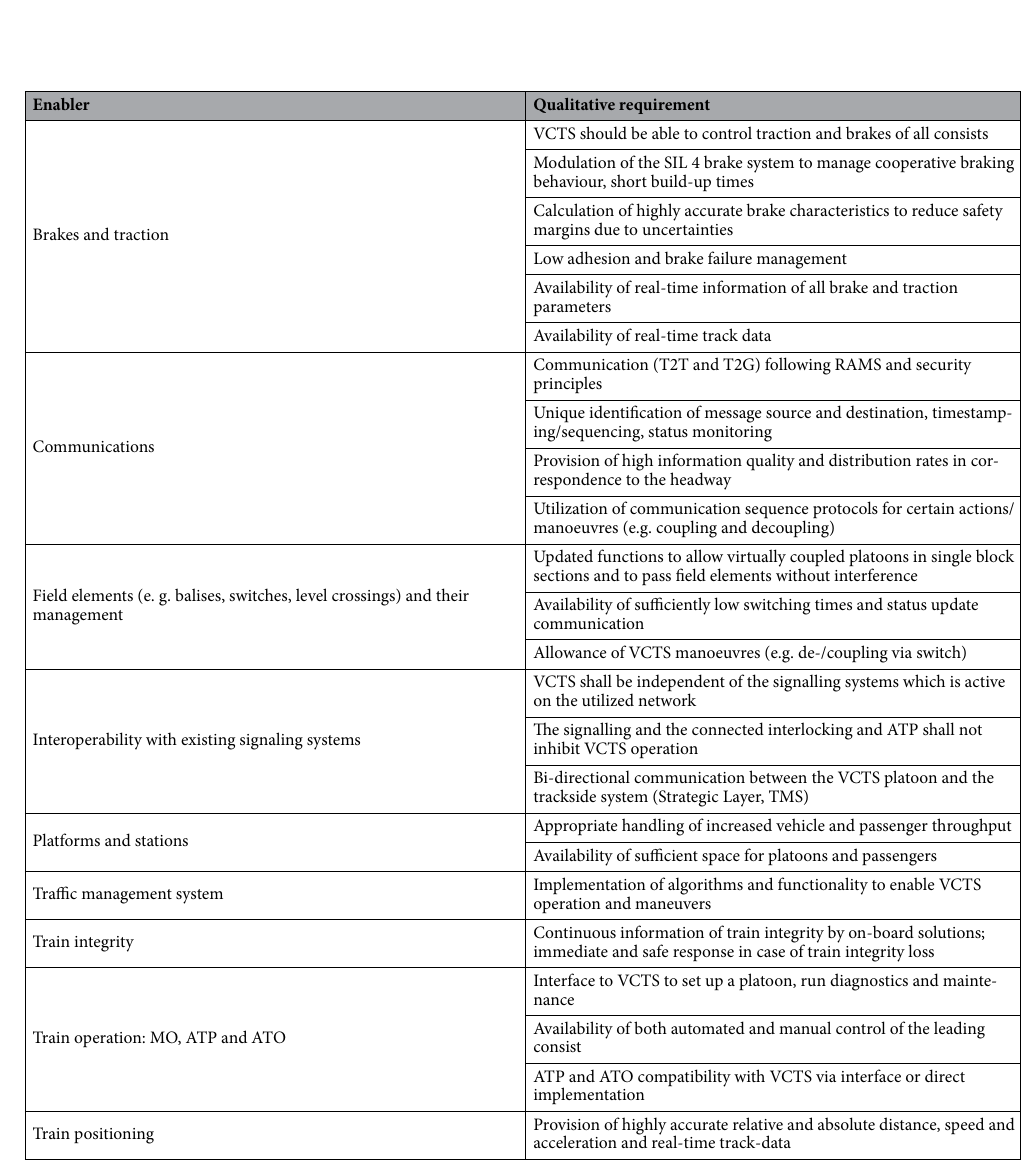
Table 2. Qualitative requirements for VCTS enablers to facilitate basic VCTS